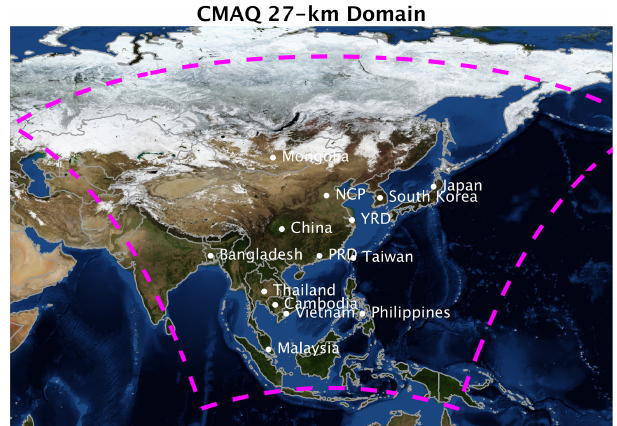
Figure 1. The CMAQ 27km domain covering the major propor- tion of Asia. The background picture is retrieved from the publicly available NASA Blue Marble (©